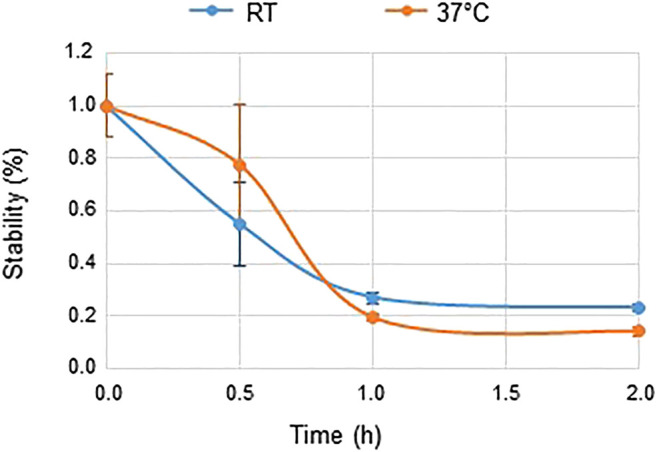
Stability of IFN-β-1b. Results represent the mean ± SD of three experiments performed in duplicate. Two way ANCOVA. Time effect, p < 0.0001. Temperature effect, p = 0.82. RT: Room Temperature 20°C.